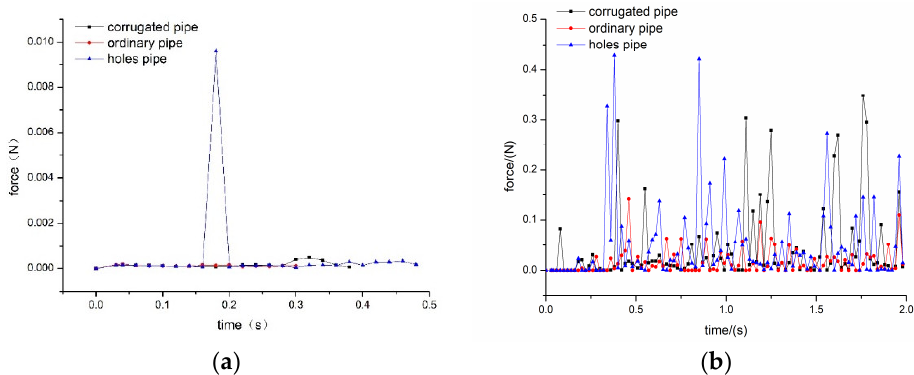
Figure 9. Force variation of single particle and maximum force diagram of particle in seed tube. ( a ) Effect of seed tube on stress of single seed; ( b ) Influence of seed tube on maximum force of seed.